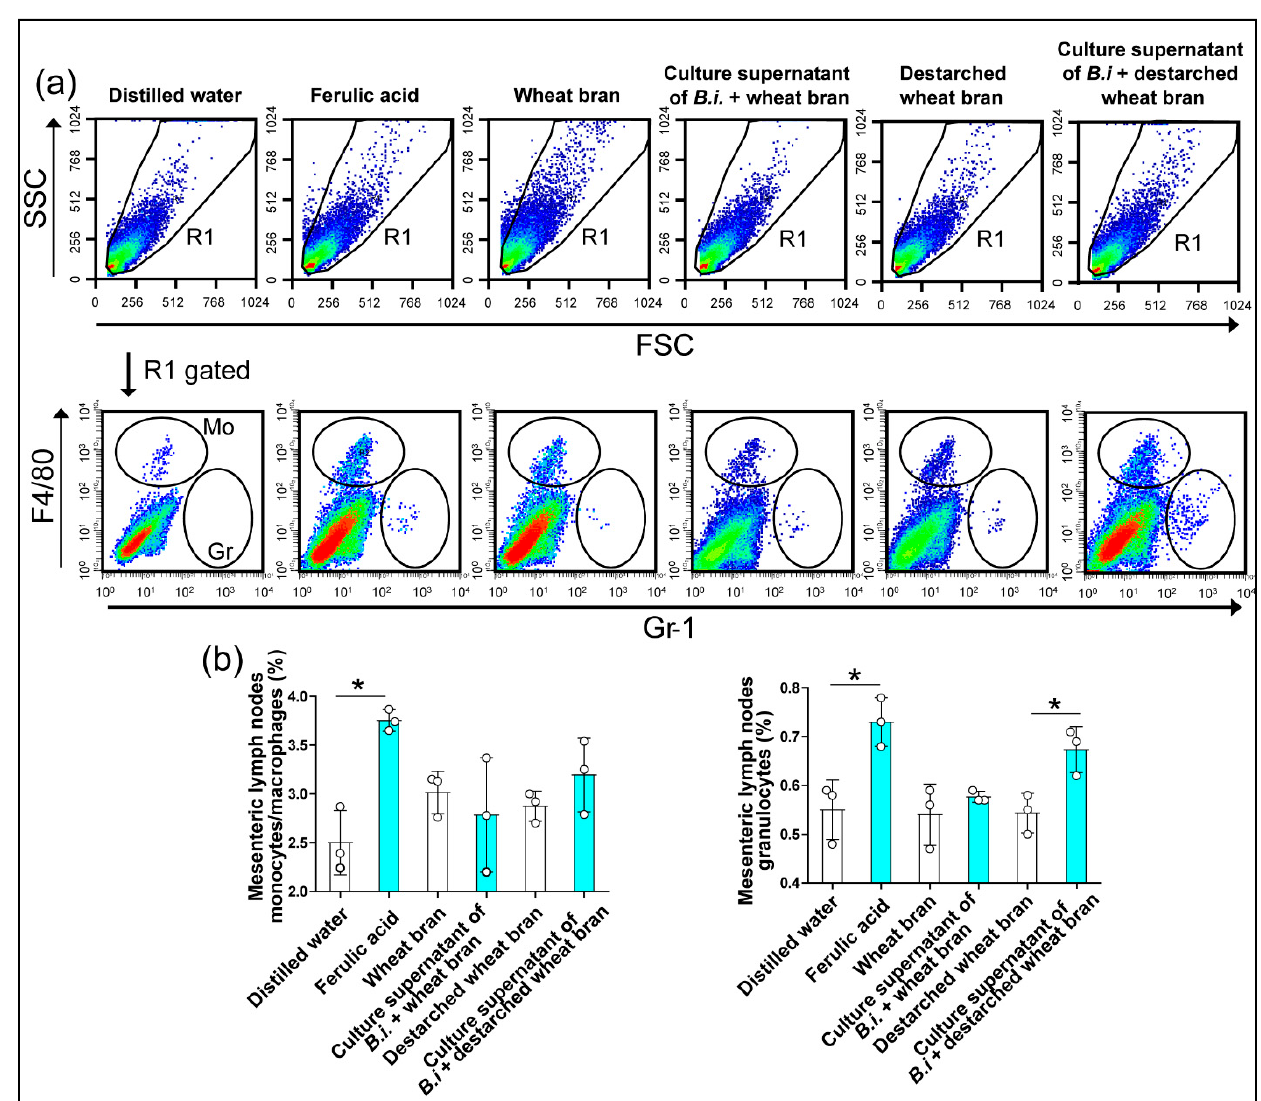
Figure 3 . The culture supernatant from Bacteroides intestinalis increased monocytes/macrophages and granulocytes in the mesenteric lymph nodes under physiological conditions. Flow cytometry analyses demonstrated an increased percentage of monocytes/macrophages and granulocytes in mesenteric lymph nodes ( a , b ) from healthy mice treated with ferulic acid or a culture supernatant of Bacteroides intestinalis (B.i.) + destarched wheat bran. The results are shown as the mean ± S.D. of one experiment. Three mice in each treatment group. Statistical analysis was performed using the Mann–Whitney U test. * p < 0.05. SSC, side scatter; FSC, forward scatter.